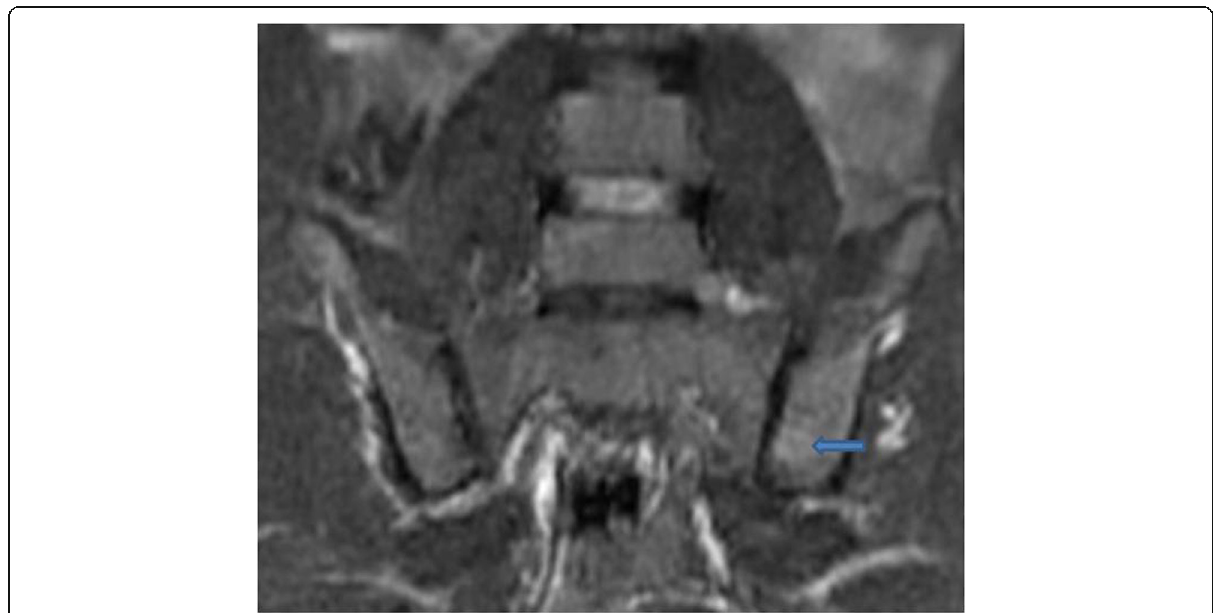
Fig. 5 MRI sacroiliac joints (coronal t2WI in 45-year-old male RA patient showing focal bone marrow edema in left SIJ (blue arrow)